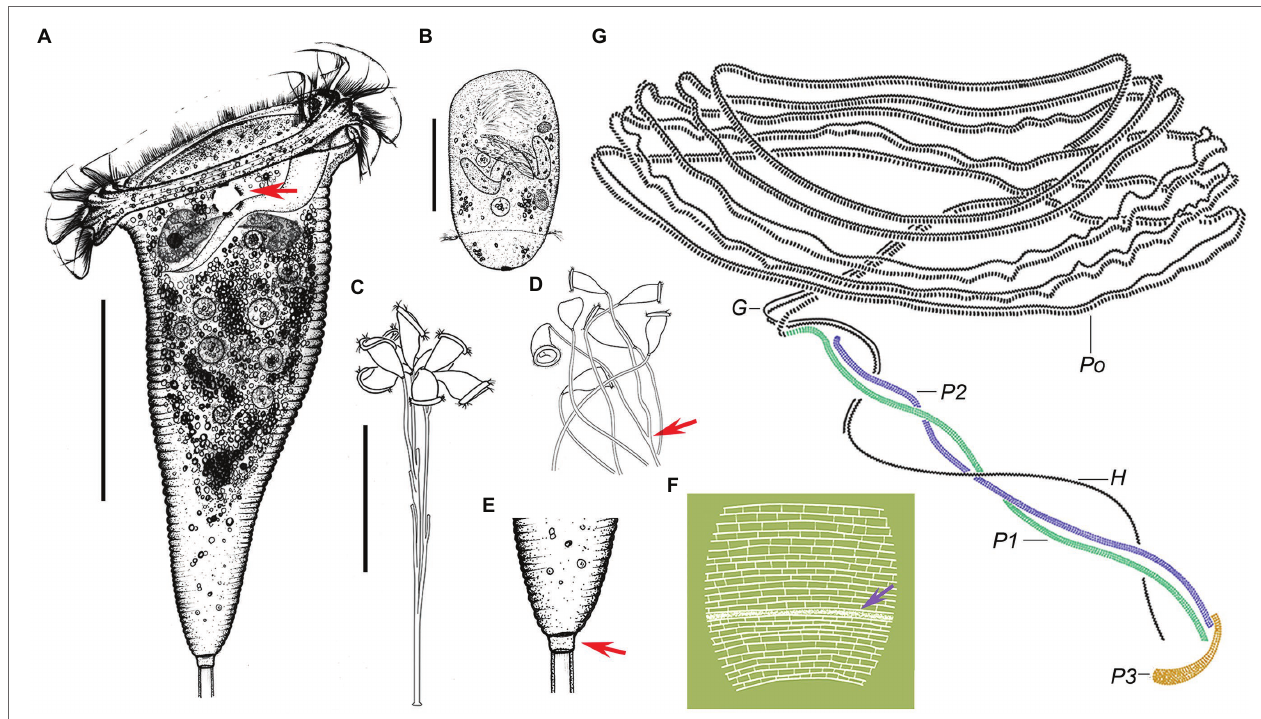
FIGURE 5 | Campanella sincia n. sp. in vivo (A–E) , after dry silver nitrate staining (F) and protargol (G) staining. (A) Typical zooid, arrow indicates the contractile vacuole. (B) Teletroch. (C,D) Immature colonies at low magnification, showing the branching pattern of the stalk, arrow in (D) shows an example of dichotomous branching. (E) Junction of stalk and zooid at high magnification, arrow shows the scopula. (F) Partial silverline system, arrow marks trochal band. (G) Oral ciliature. G, germinal kinety; H, haplokinety; Po, polykinety; and P1–3, infundibular polykineties 1–3. Scale bars: 50 μ m in (A,B) ; 100 μ m in (C) .